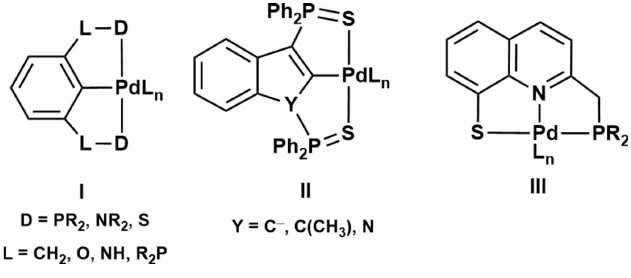
Figure 1 Schematic representation of Pd pincer complexes I – III